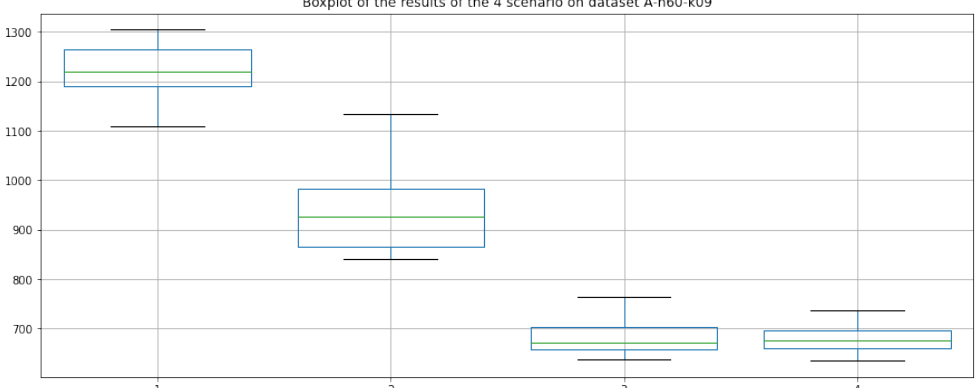
Figure 12. Boxplot of scenarios on the A-n55-k9 task of ABEFMP.